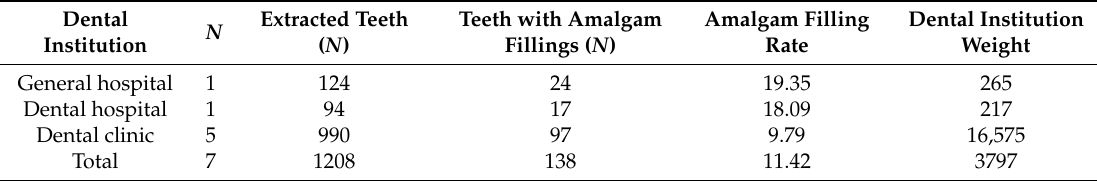
Table 1. Amalgam filling rate by dental institution.